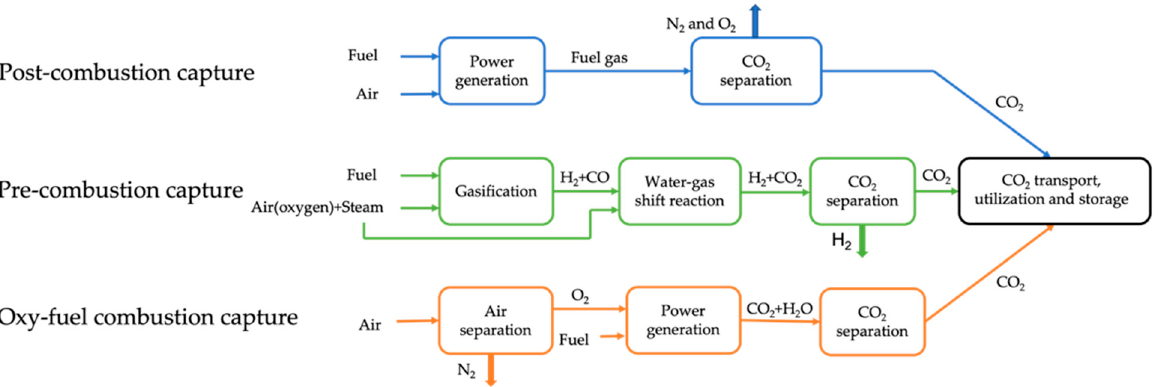
Figure 3. Schematic flow diagrams of post-combustion capture, pre-combustion capture and oxy-fuel combustion capture. Table 3. Comparison of CO 2 capture technologies [57].